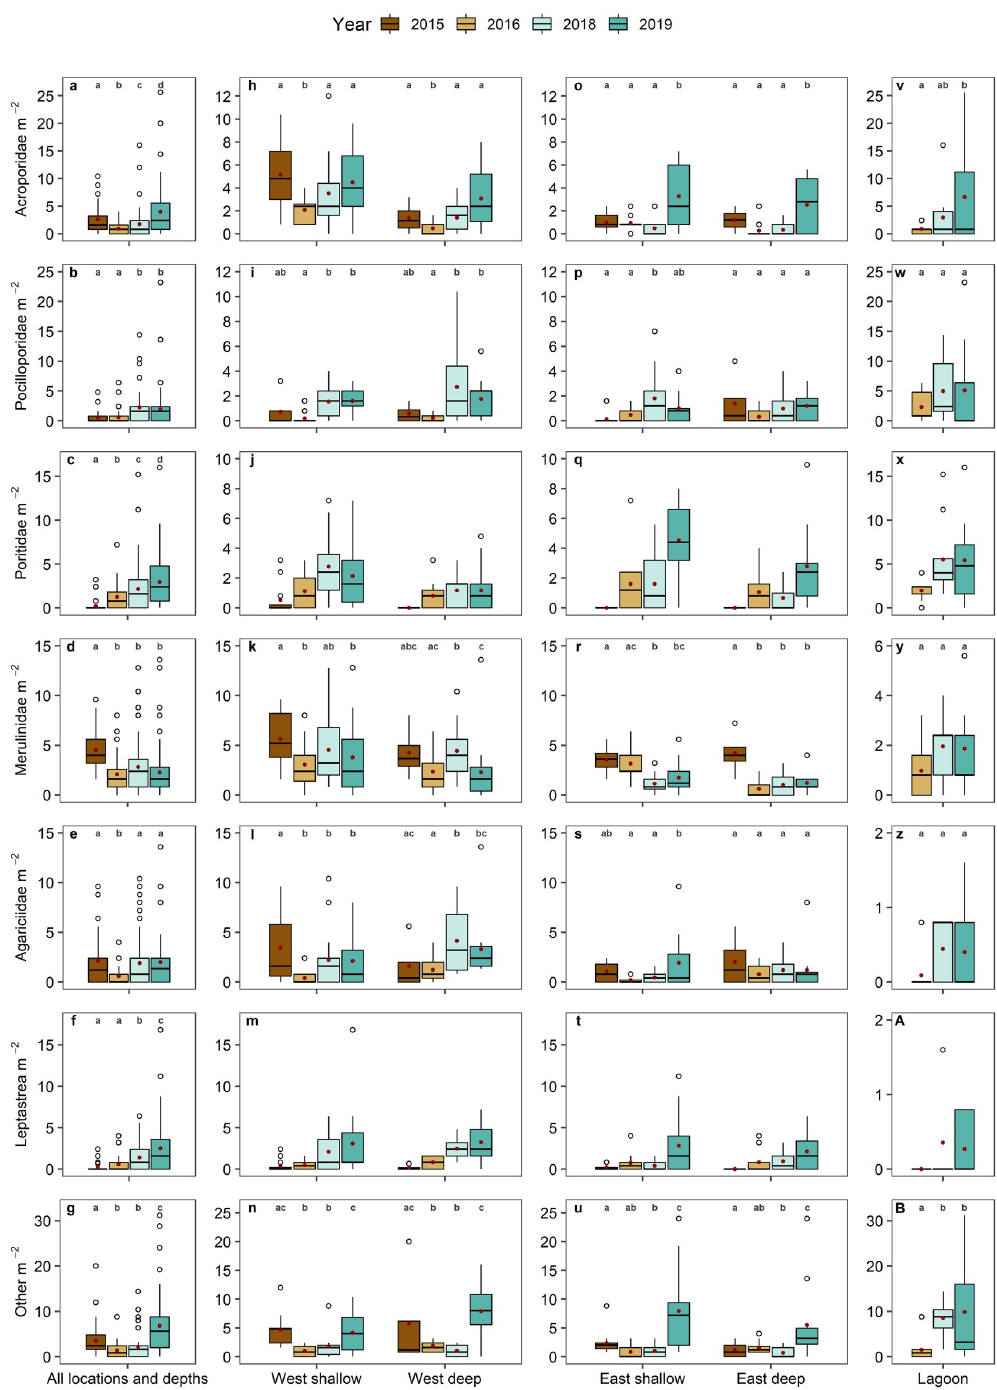
Fig 3. Coral juvenile abundance of the most abundant taxa across locations and years. Displayed are coral juvenile abundances across all locations and depths (a–g) and at the seaward locations (h–u) during 2015–2019 and the lagoon (v–B) during 2016–2019. Plots show median and interquartile range with outliers displayed as circles and means displayed as red dots. Note the different y-axis scaling. Small letters above boxplots indicate significant differences ( p < 0.05) in abundances between years within locations and depths (see S3 Table). Note that only overall changes across years could be statistically tested for Poritidae and Leptastrea (see Methods).